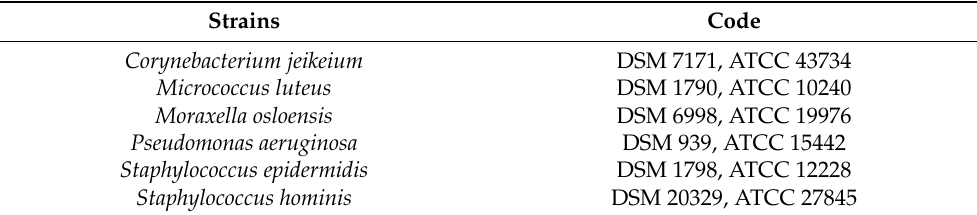
Table 1. Bacterial test strains.